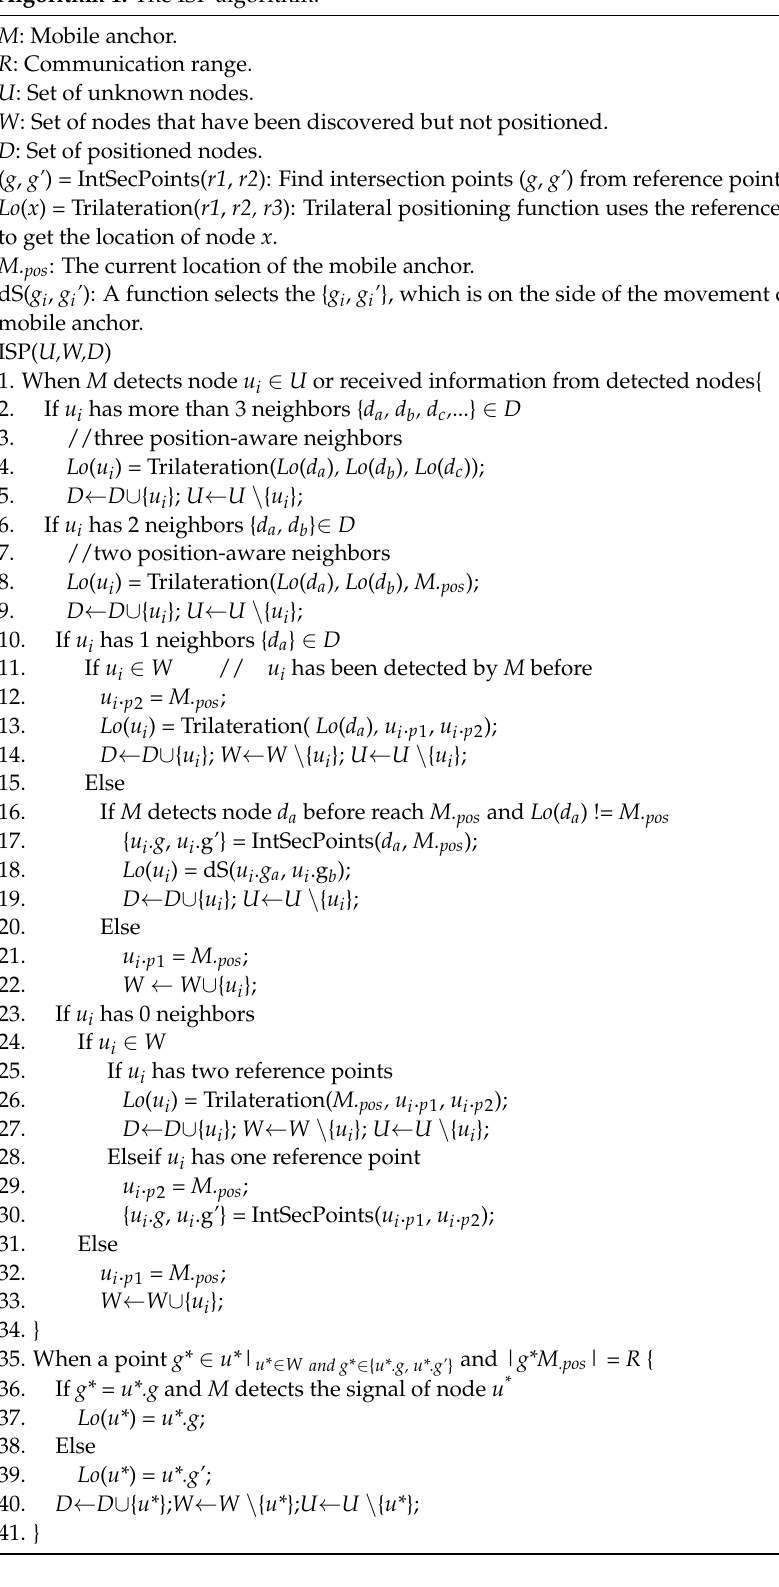
Algorithm 1. The ISP